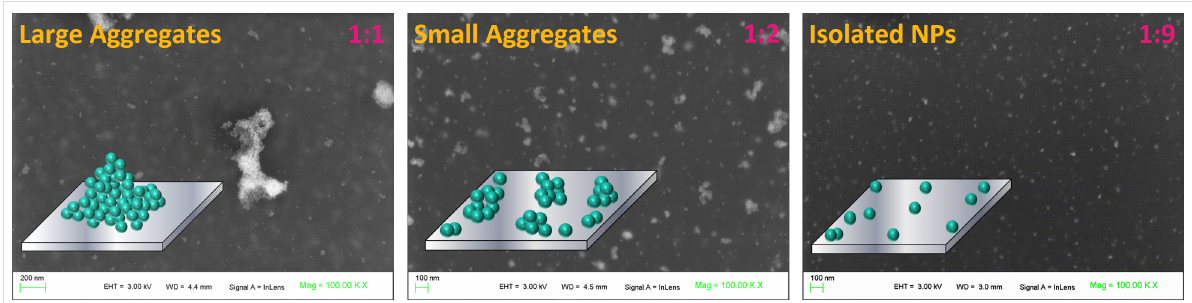
Figure 10: SEM images of various assemblies of ENP-PMMA, obtained by drop casting from THF suspension with ENP/PMMA ratios of 1:1, 1:2 and 1:9.